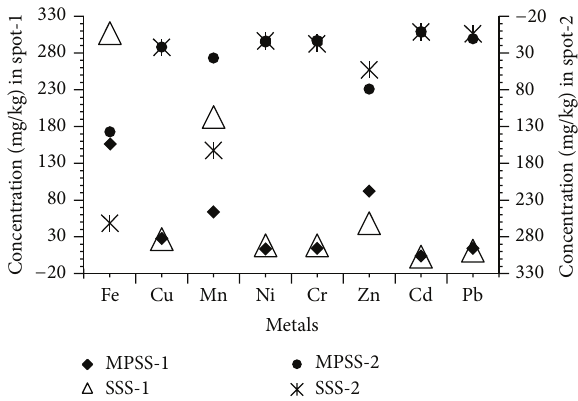
Figure 1: Average metals contents in medicinal plants and soil sample. MPSS: medicinal plants samples of spot: SSS: soil samples of